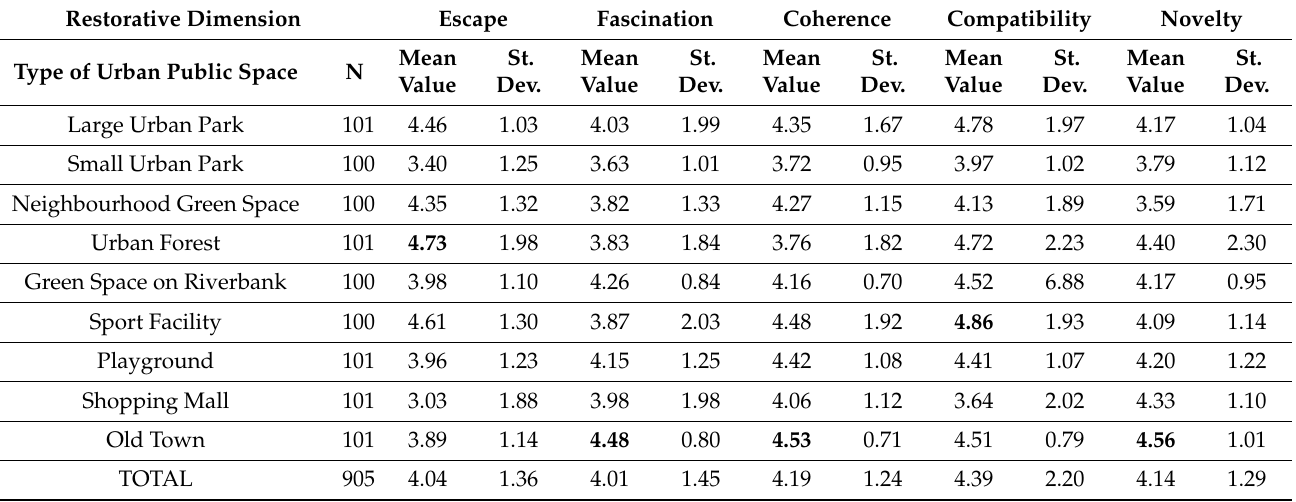
Table 4. Extent to which the restorative dimensions differ in 9 selected urban public